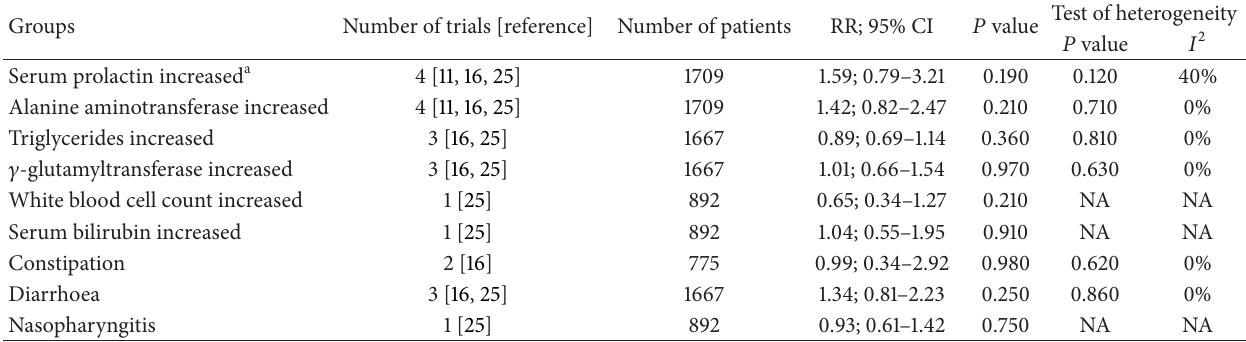
Table 4: Pooled RR of adverse events in FD patients receiving acotiamide versus placebo by Mantel-Haenszel fixed-effect model.